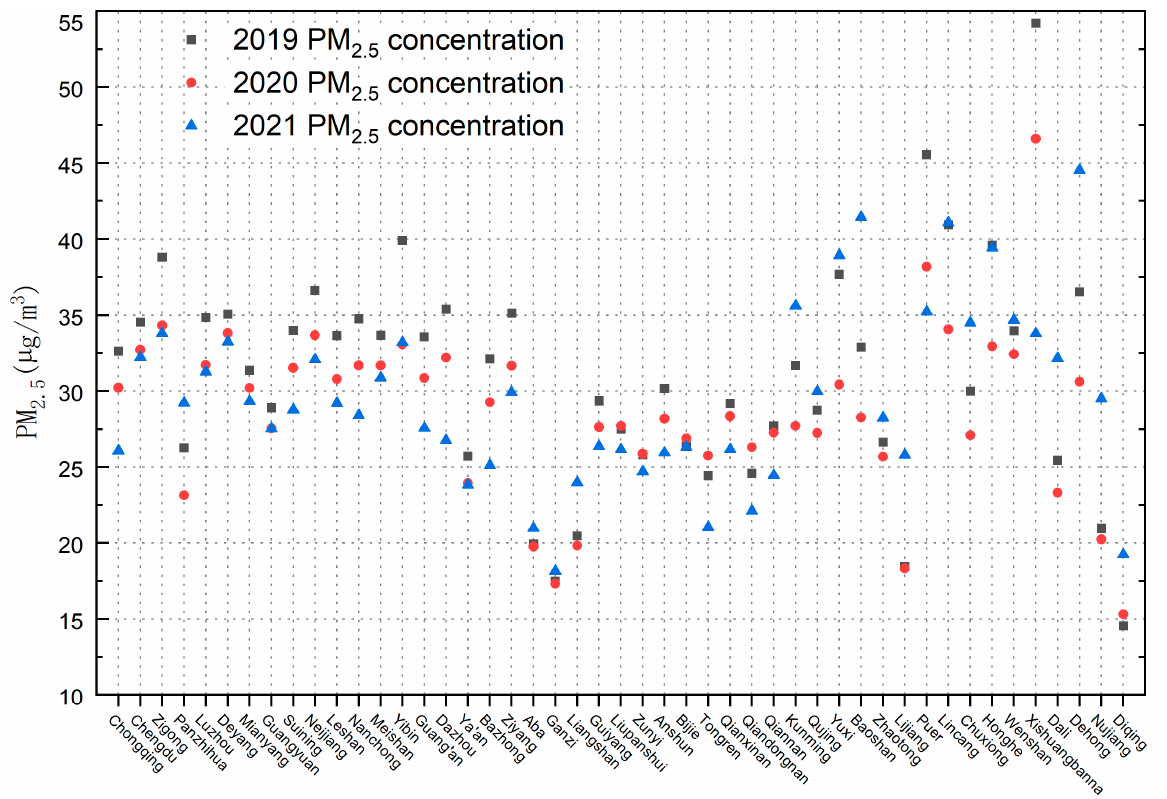
Figure 8. Changes in PM 2.5 concentration in cities of southwest China in spring.